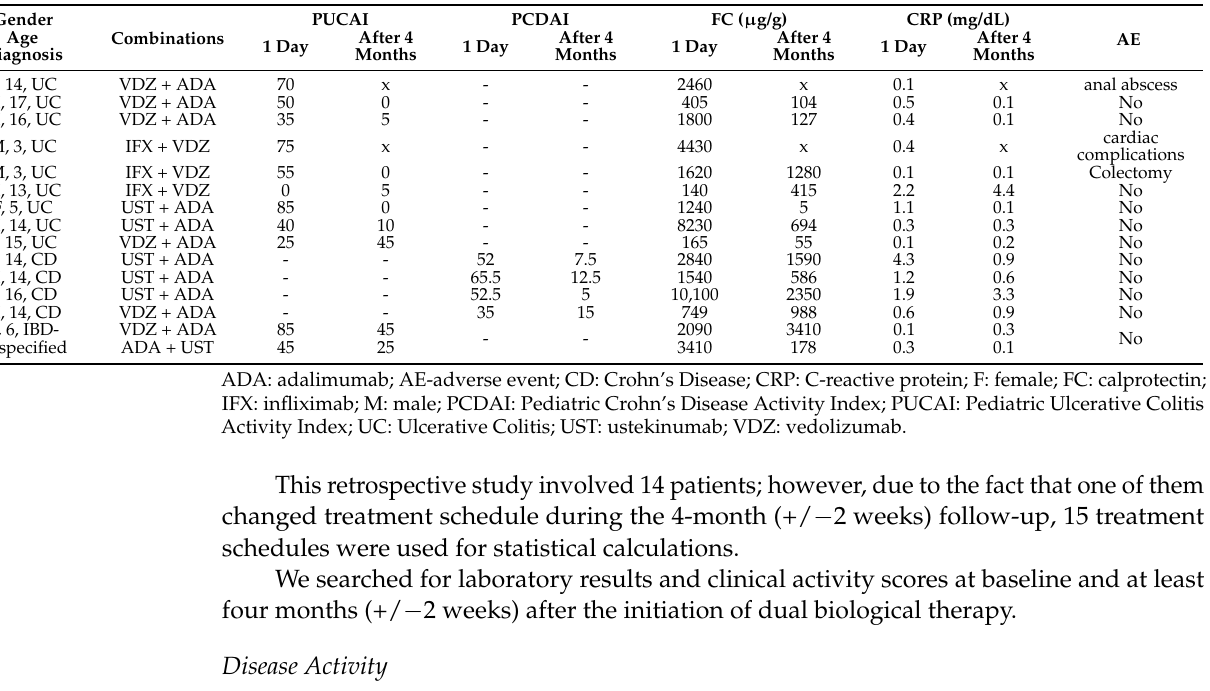
Table 2. Comparison characteristics of patients and response to treatment in dual biological